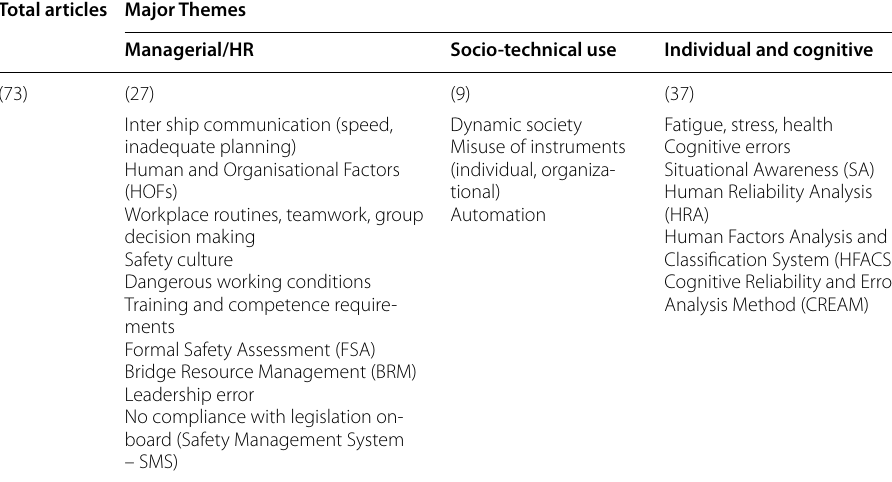
Table 6 Cluster A: main topics discussed in articles Total articles Major